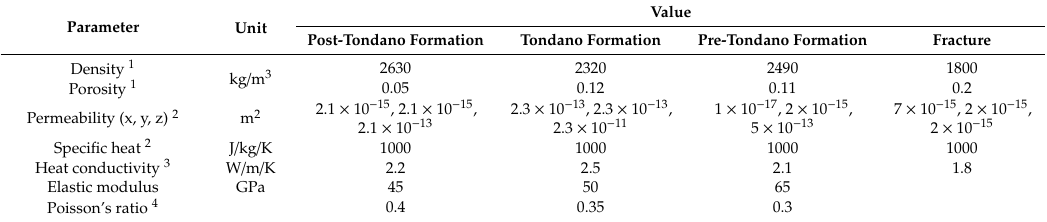
Table 4. Parameters of rock matrix and fracture properties.